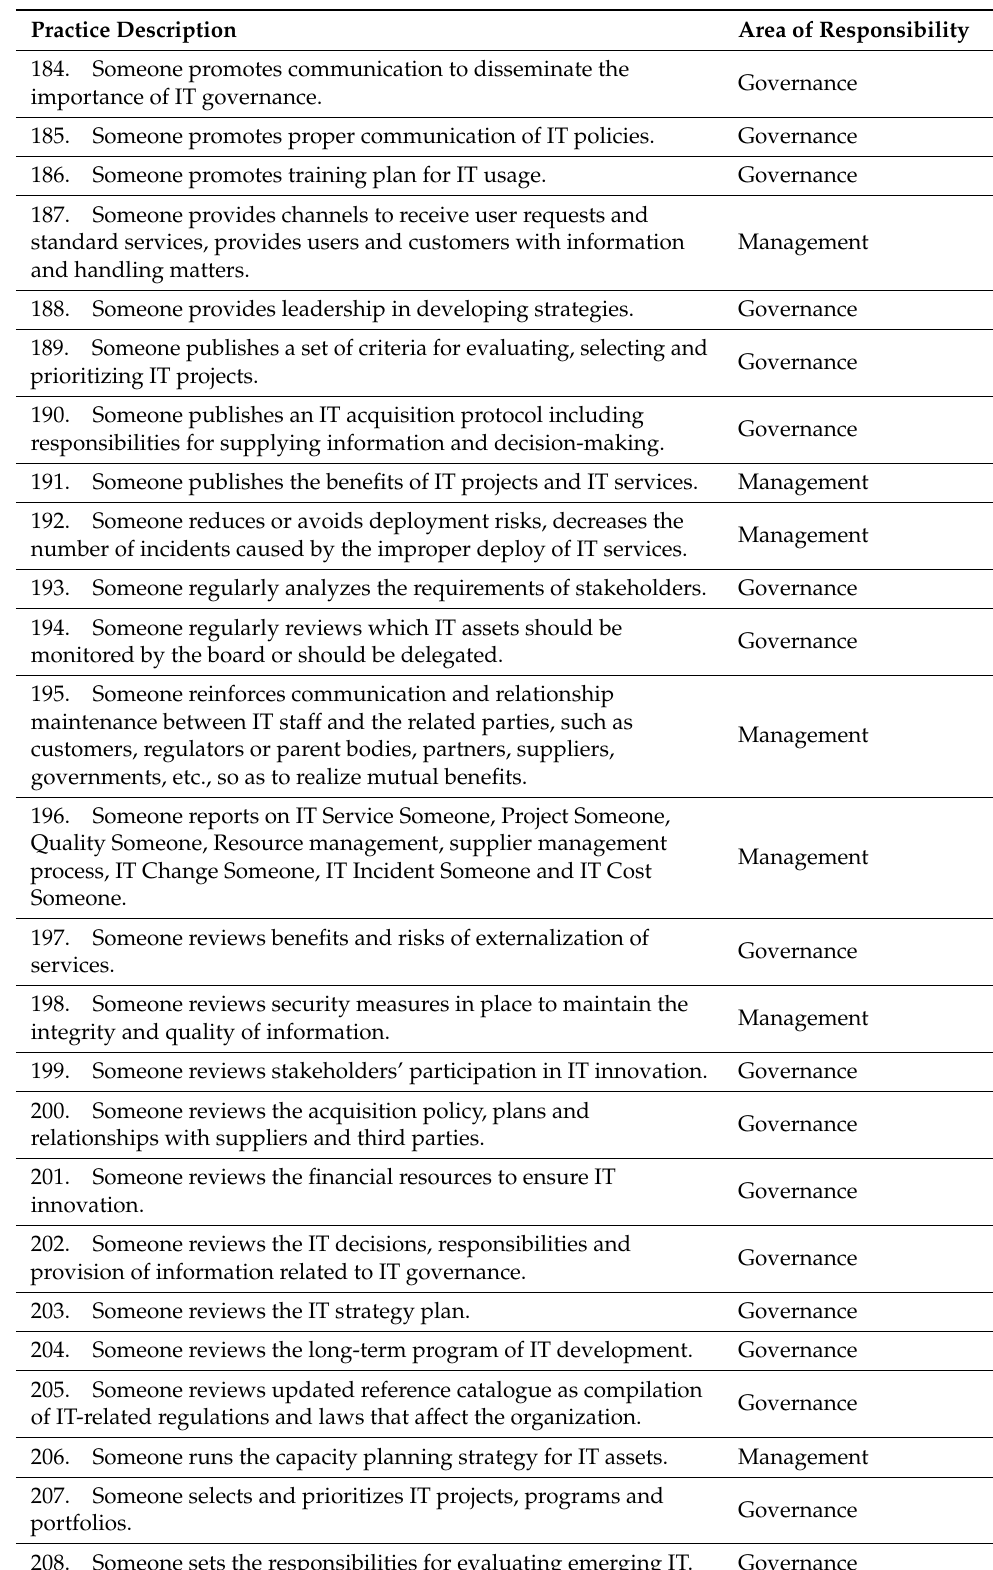
Table A1. Cont. Practice